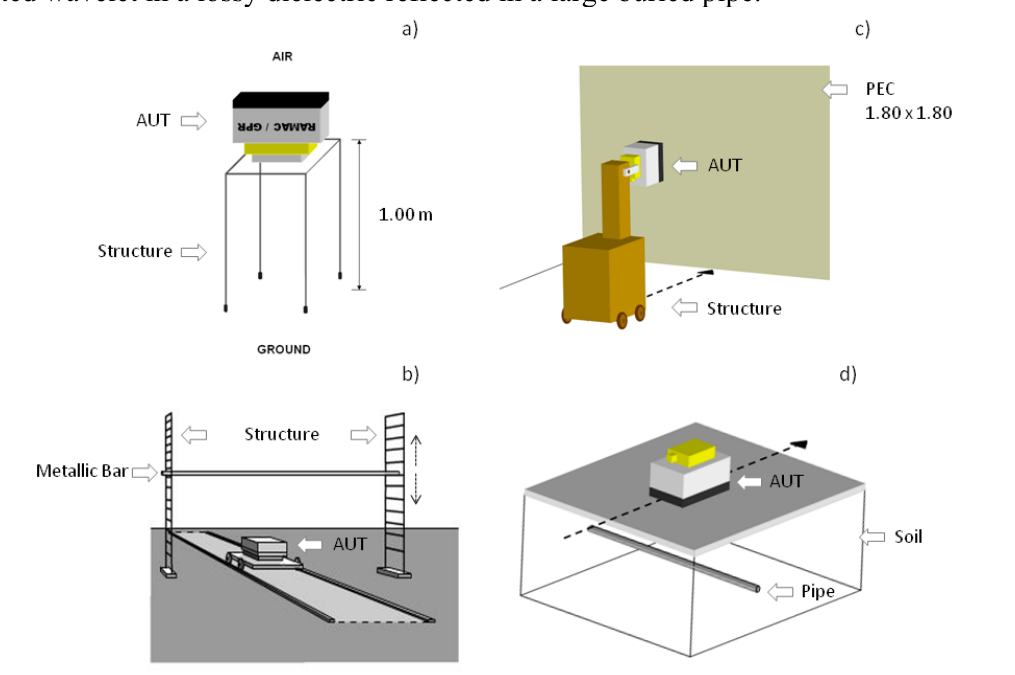
Figure 4 . Methodologies used during the tests to obtain: (a) Direct signal between dipoles in a reflector-free environment. (b) Emitted wavelet in air reflected in a metallic bar at different distances. (c) Emitted wavelet in air reflected in a PEC at different distances. (d) Emitted wavelet in a lossy dielectric reflected in a large buried